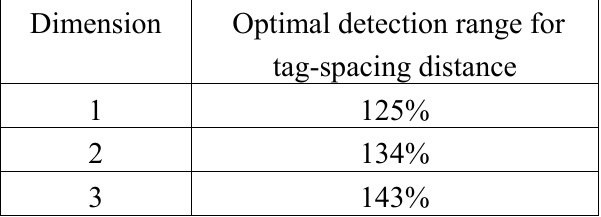
Table 5. Simulation results for 1-, 2- and 3-dimensional spaces.